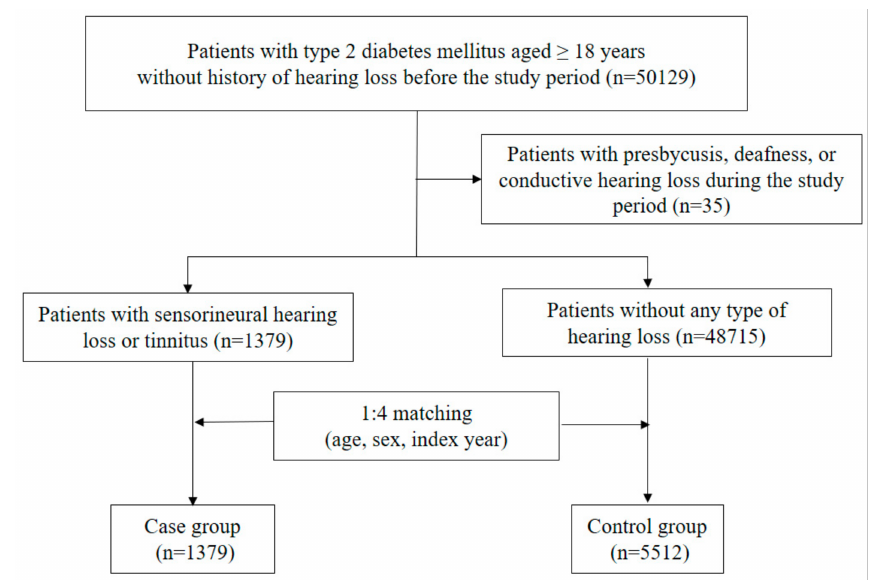
Figure 1. Flowchart for selection of cases and